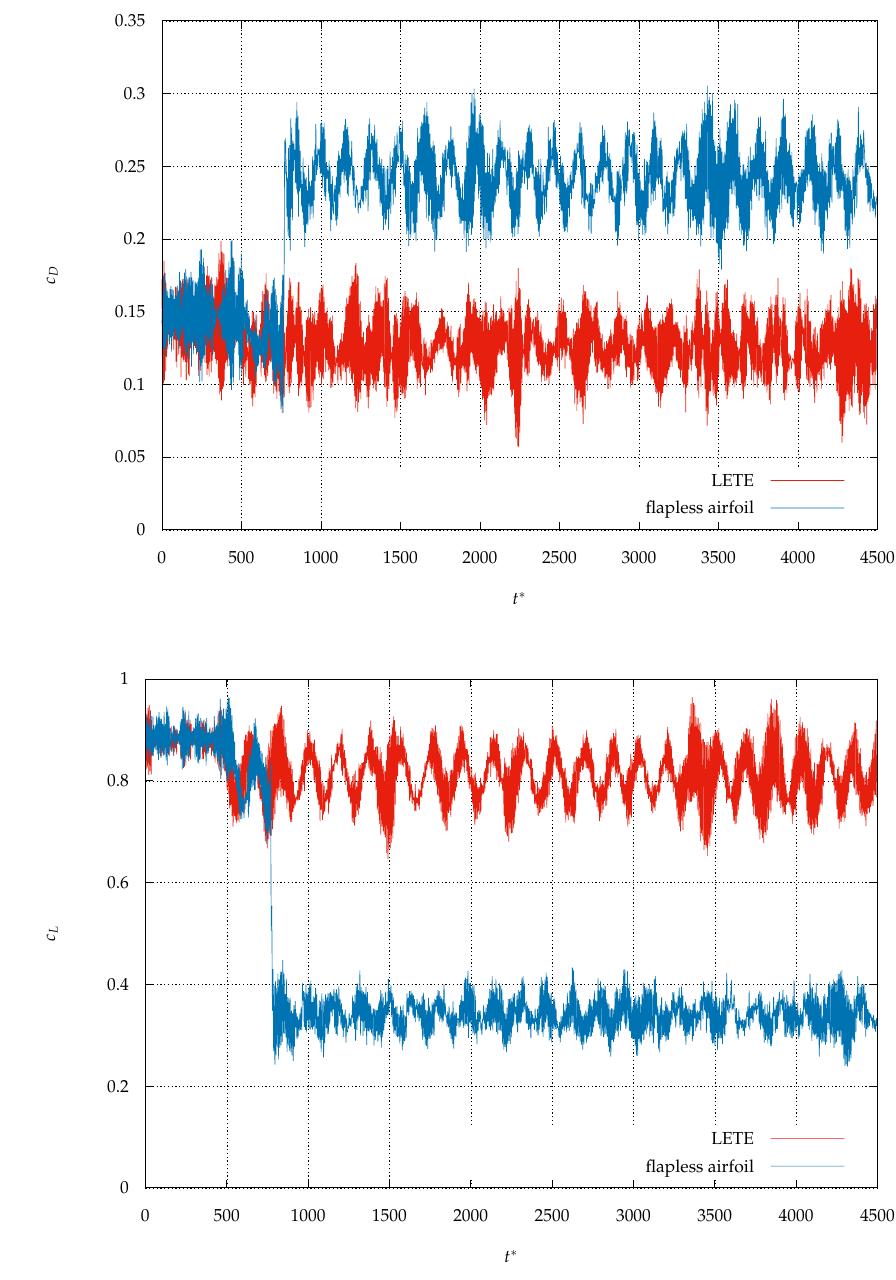
Figure 13. ( a ) Drag and ( b ) lift coefficients for the gust simulation for an NACA0020 profile with and without flaps; the angle of attack for flapless airfoil is 21.5°; for the LETE configuration, it is